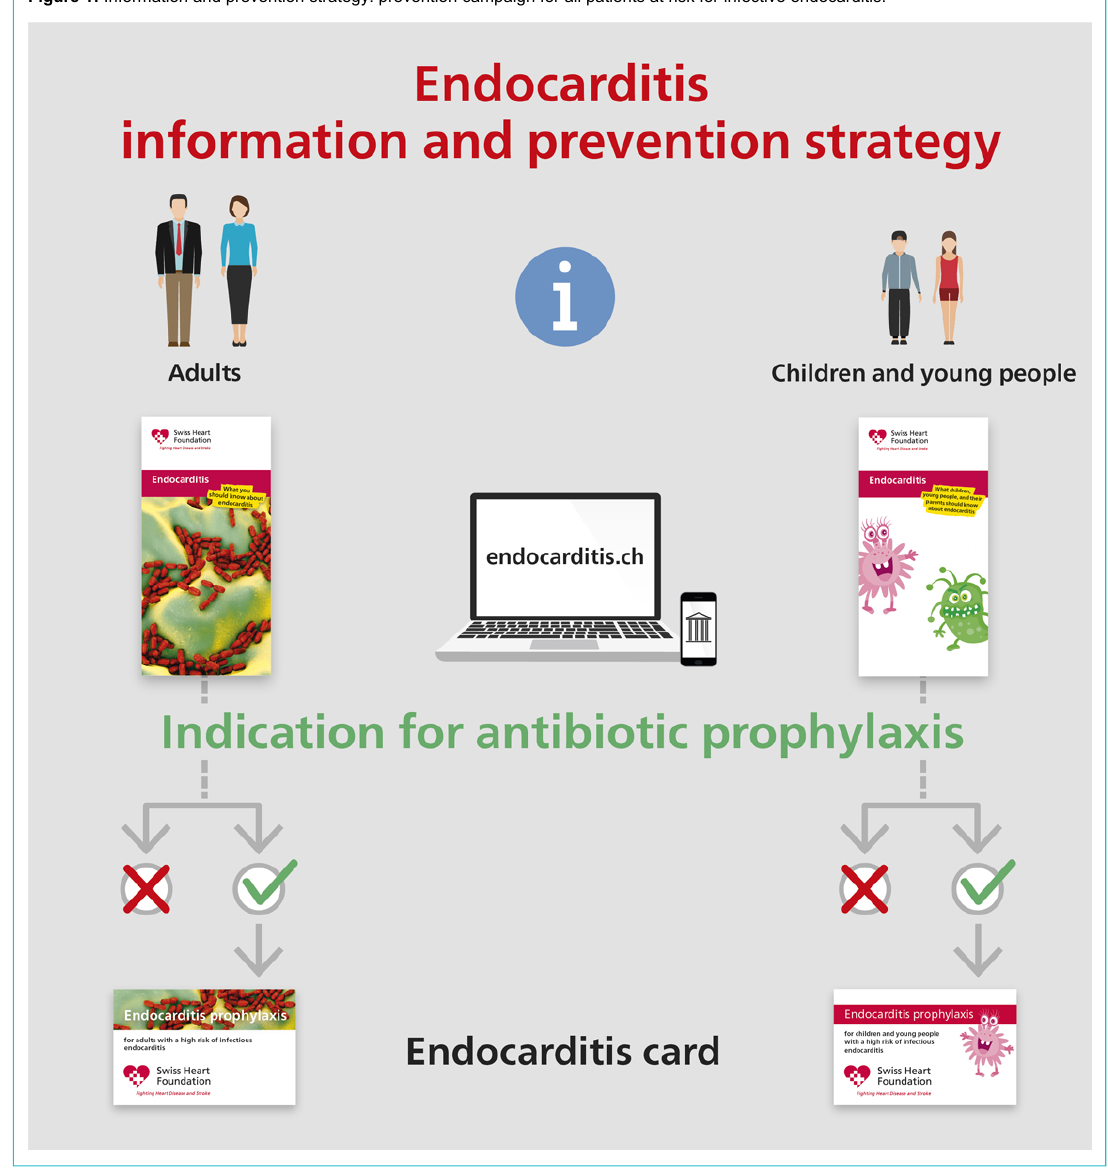
Figure 1: Information and prevention strategy: prevention campaign for all patients at risk for infective